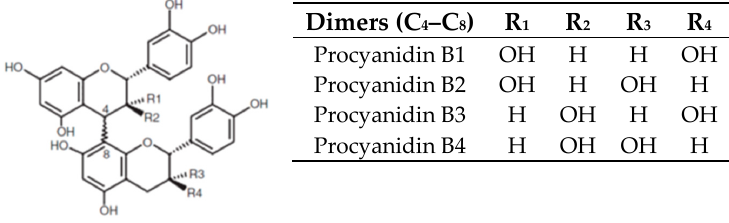
Figure 3. Monomeric flavanols and procyanidins structures found in grapes.